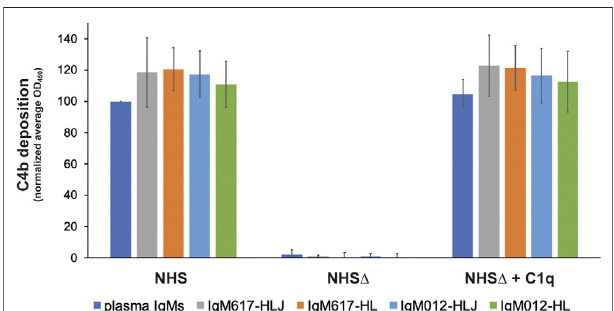
FIGURE 5 | Complement activation by the different puri fi ed IgM constructsexpressedinHEK293F.RecombinantIgMsandIgMspuri fi edfrom plasma were coated on microplate wells and incubated with either normal human serum (NHS), C1q-depleted NHS (NHS Δ ), or reconstituted NHS (NHS Δ +C1q).C1activitywasmonitored via C4bdeposition.Reportedvalues are average of replicated (2 – 4) normalized experiments (100% = IgM plasma/ NHS). Errors are obtained as standard deviation between independent